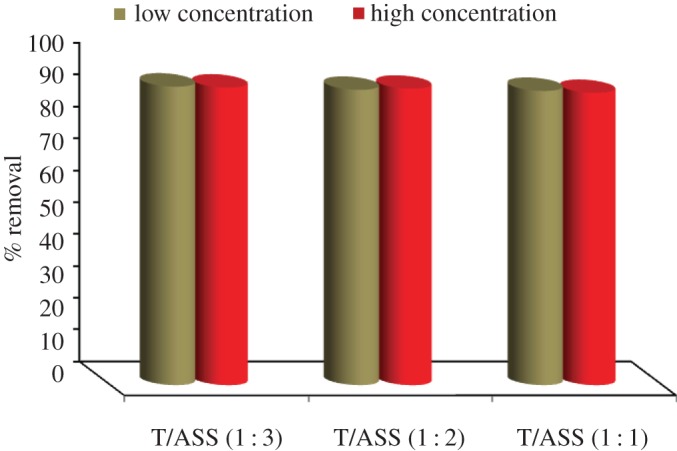
Removal efficiency of MO by TiO2/ASS (1 : 3, 1 : 2 and 1 : 1) at low and high MO and Cd2+ initial concentration.